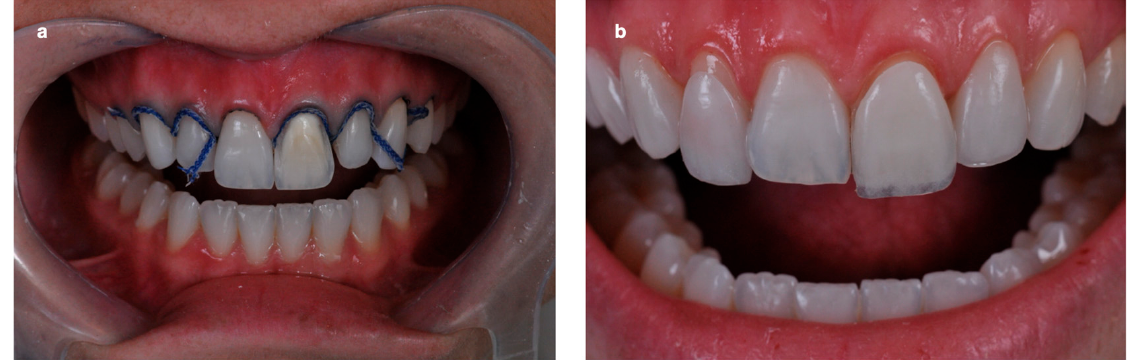
Figure 5. ( a ) Intra-sulcular cords positioned before impression with vinyl polyxiloxane. ( b ) Feldspathic ceramic veneer being positioned for luting procedure on the upper left incisor. Visible transparency on the incisal region can be noticed due to the methodology applied in this case promoting a ceramic fi nishing line at zero-degree.